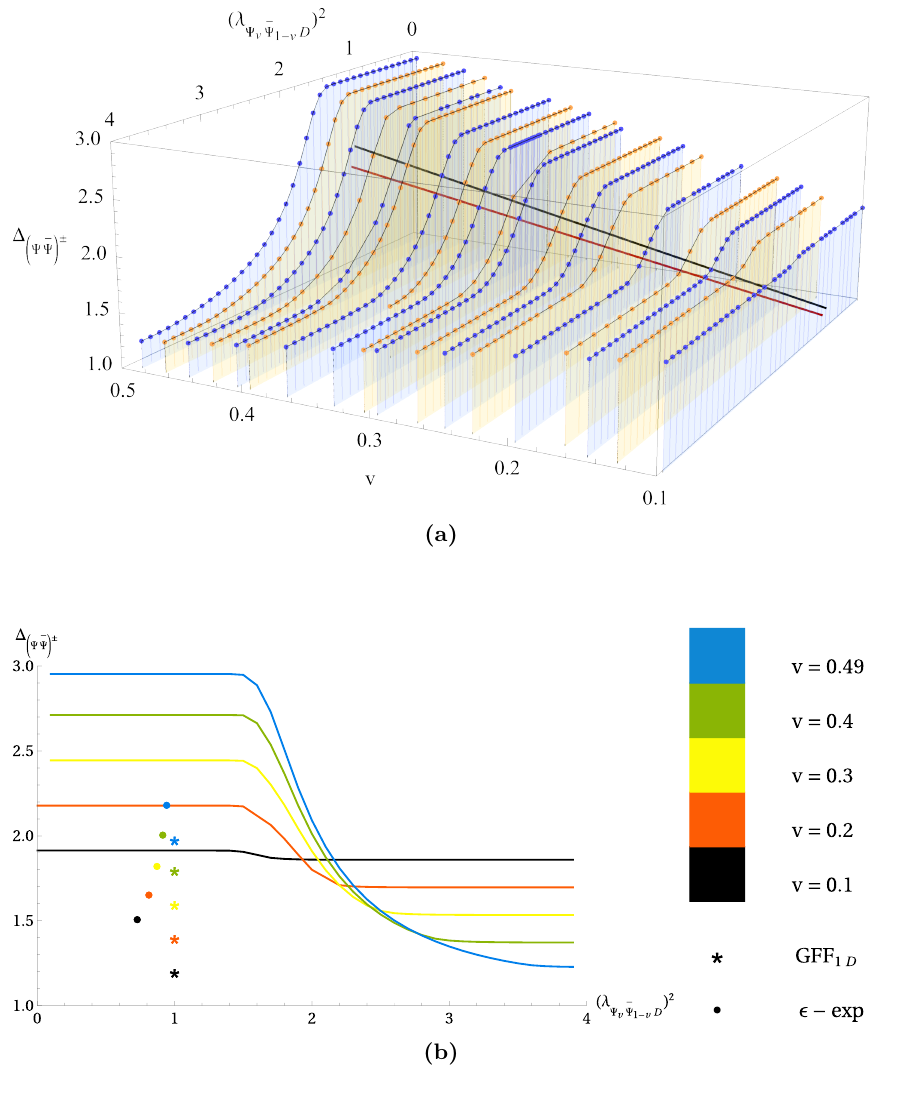
Figure 7. Bounds on the dimension of the first singlet in the Ψ s × ¯Ψ s OPE ∆ OPE coefficient of the displacement operator and the monodromy v . The gaps on the dimension of the lowest-lying operators in all other channels is set to the unitarity bound. Parity-even and odd operators are set to have the same gaps. The gray line corresponds to the ε -expansion results. Λ = 21 , P = 41